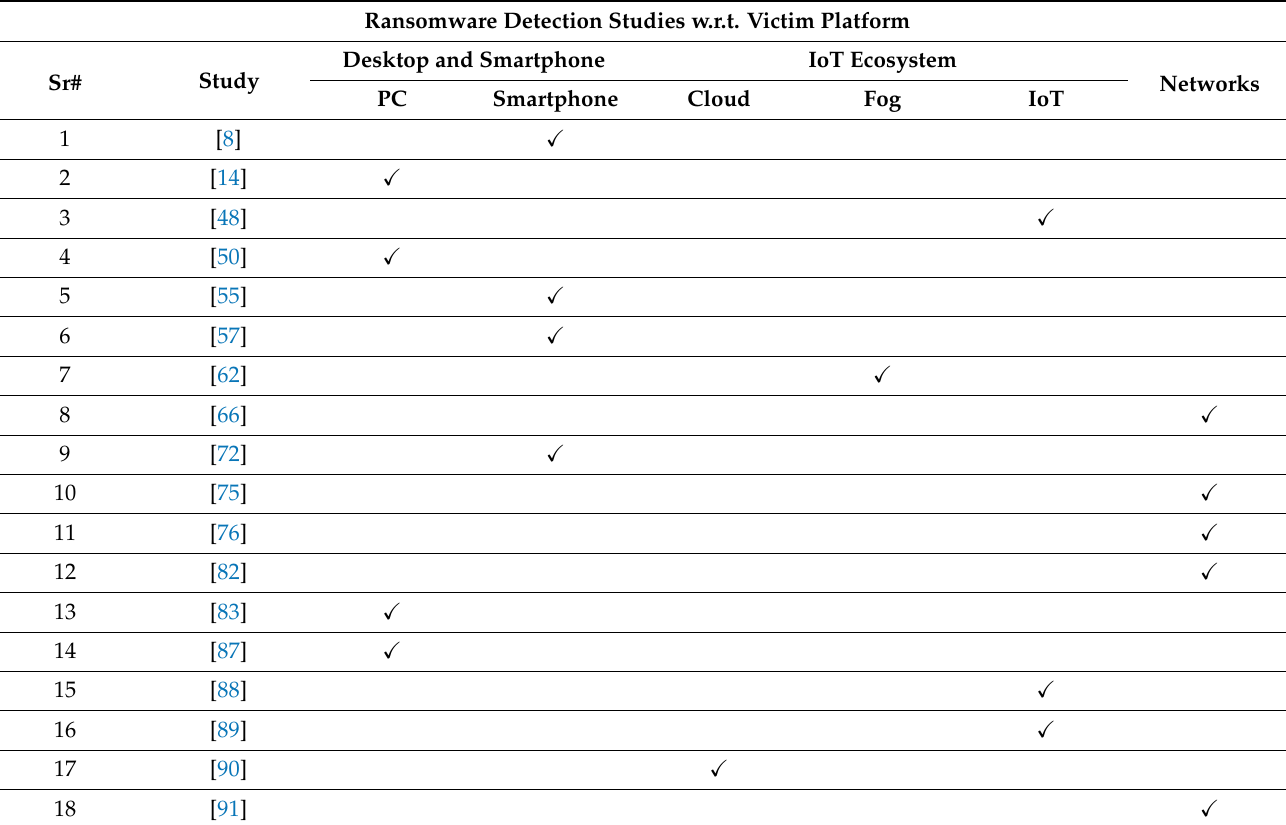
Table 2. Ransomware detection studies w.r.t. compromised